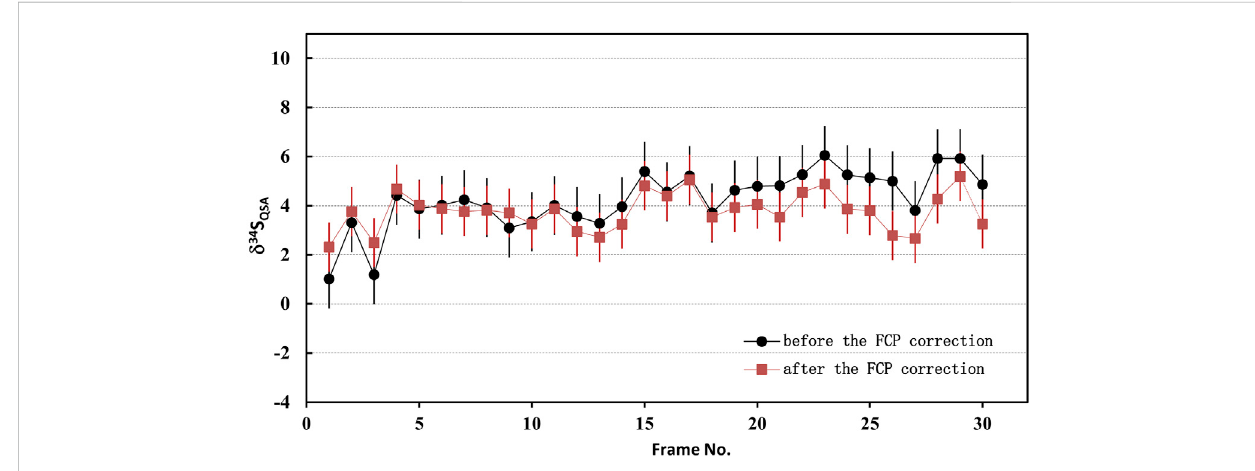
FIGURE 6 The plot of the S isotopic results before and after FCP correction measured on PY-SRZK pyrite